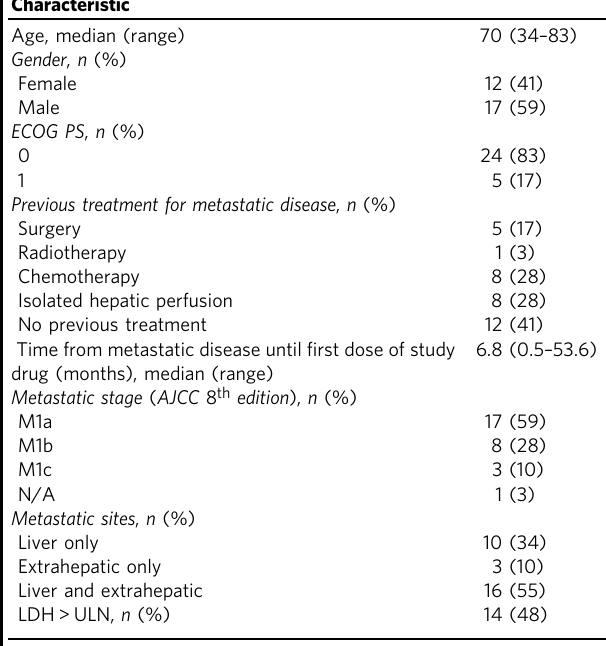
Table 1 Baseline patient characteristics ( n = 29